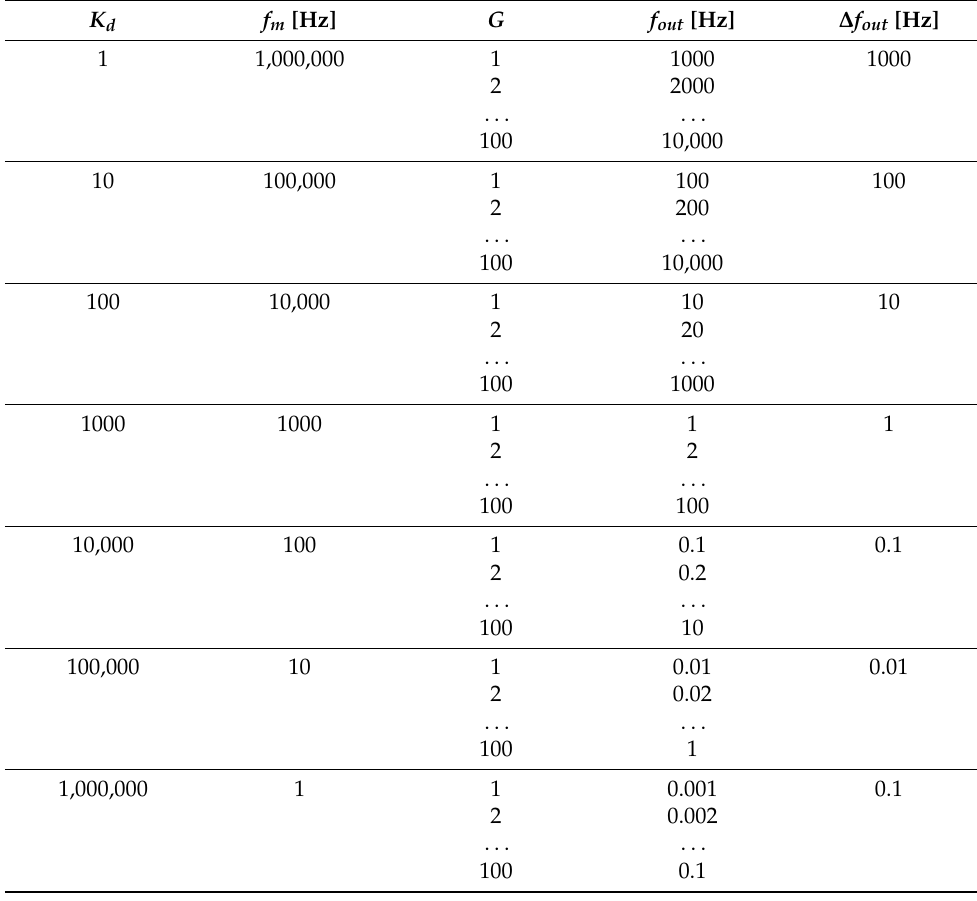
Table 3. PPSG parameters with additional